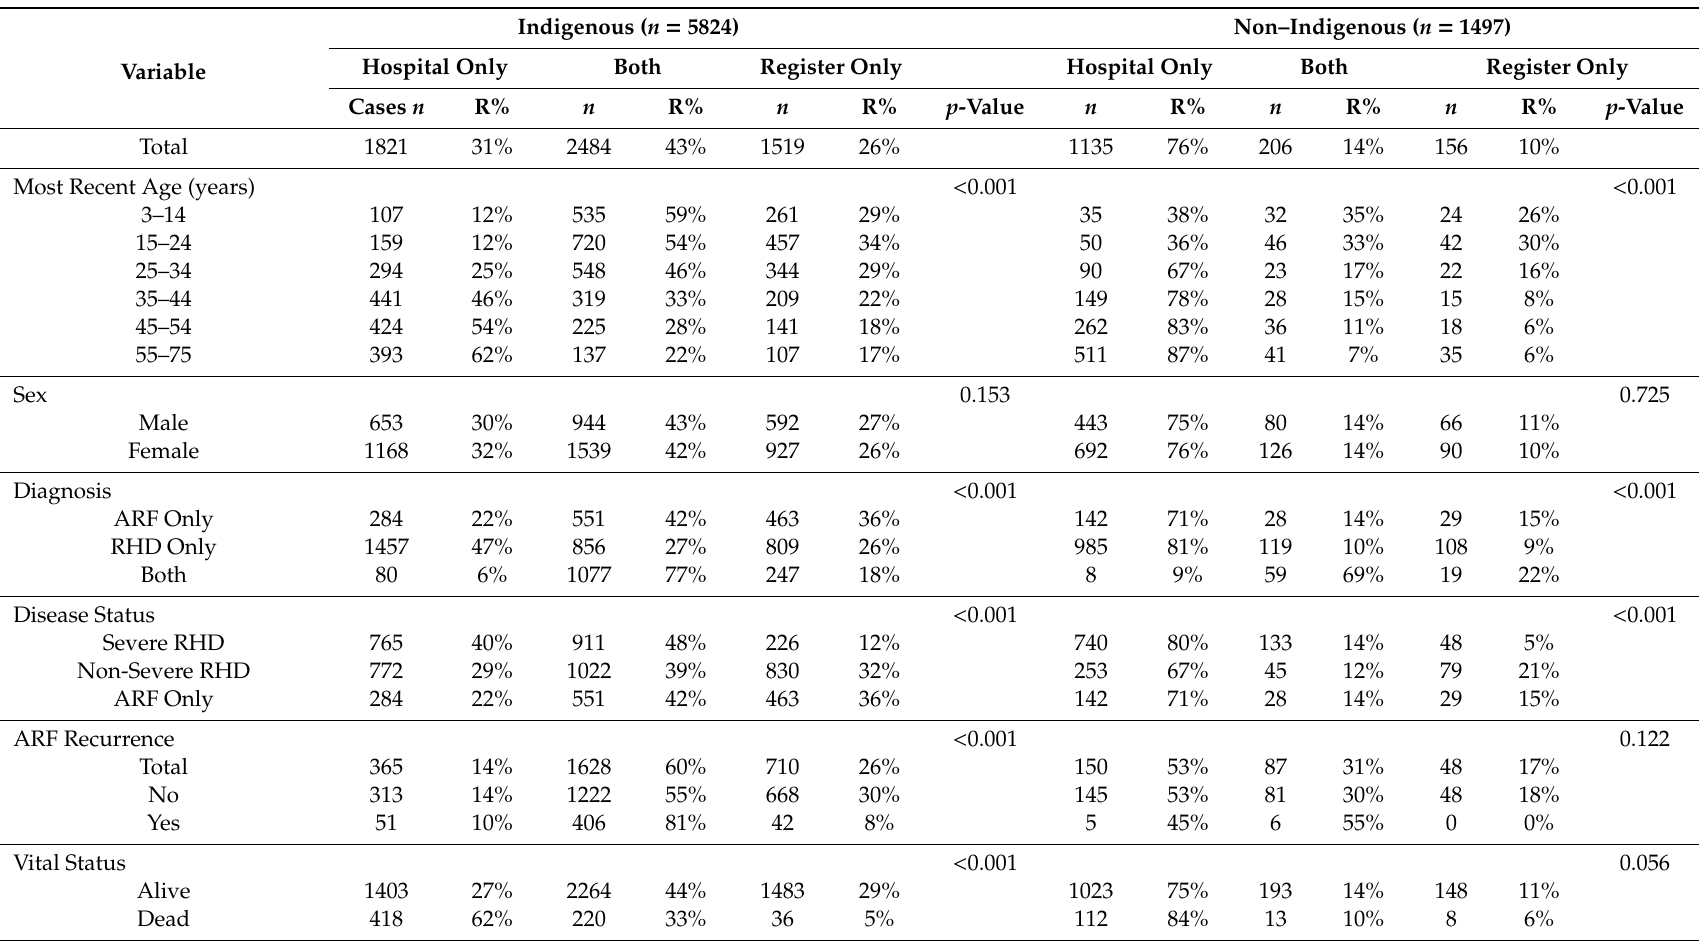
Table 1. Descriptive analysis of the study samples by Indigenous status and data